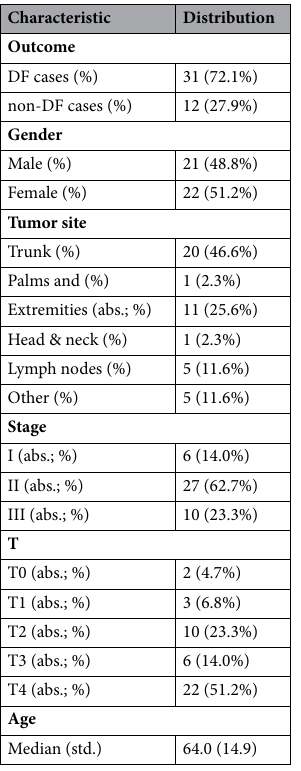
Table 1. Clinical data referred to CPTAC-CM public dataset. For categorical variables, percentage (%) counts are reported. For continuous values, the median and standard deviation (sd.) values are indicated. The abbreviation DF stands for disease free. Among the five patients for which the tumor site has been labelled as ‘Other’, more detailed specifics about the tumor site were available online. For two of these patients, the primary site was specified to be unknown. The other three tumor sites were the left shoulder, the right shoulder and the IV toe of the left foot,